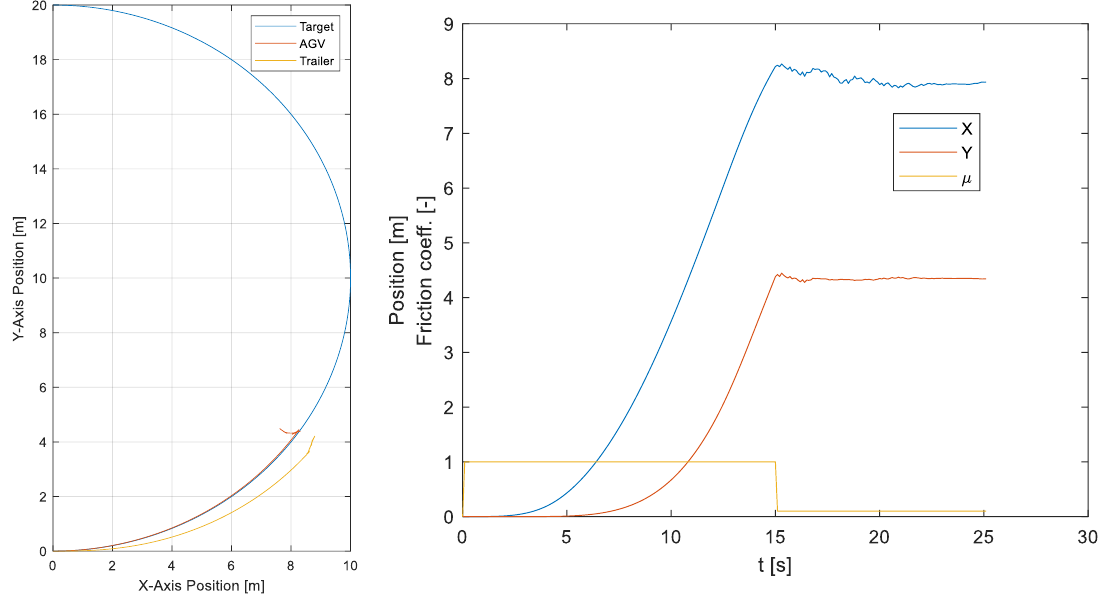
Figure 25. Trajectory followed by the AGV and the trailer with an abrupt change in the lateral friction.